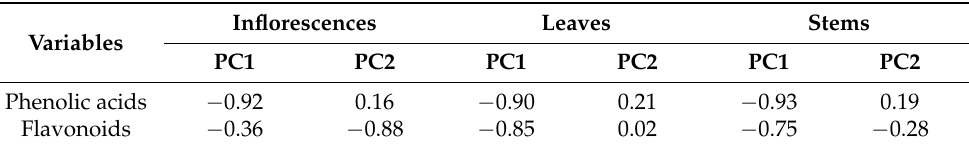
Table 5. PCA2 results based on Pearson correlation matrix between Achillea millefolium total phenolic acids and flavonoids in plant organs and the two principal component